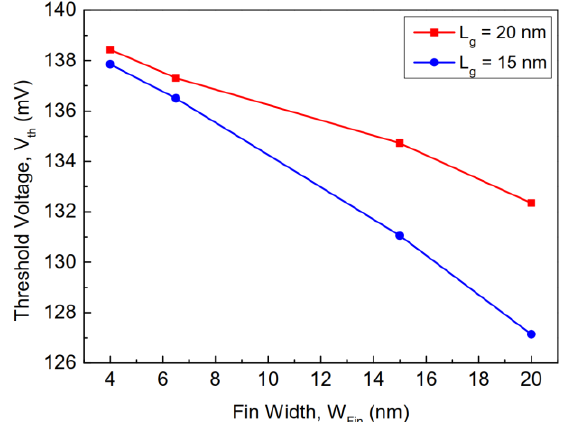
Figure 19. Transfer characteristics logarithmic scale for FinFET devices with different gate lengths at V ds = 0.8 V.